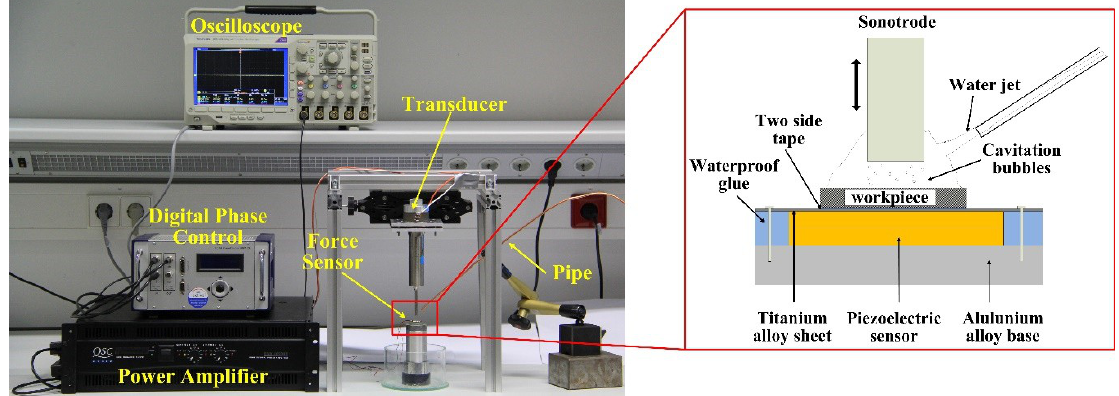
Figure 2. Experimental setup of the novel ultrasonic cavitation peening and the partial schematic